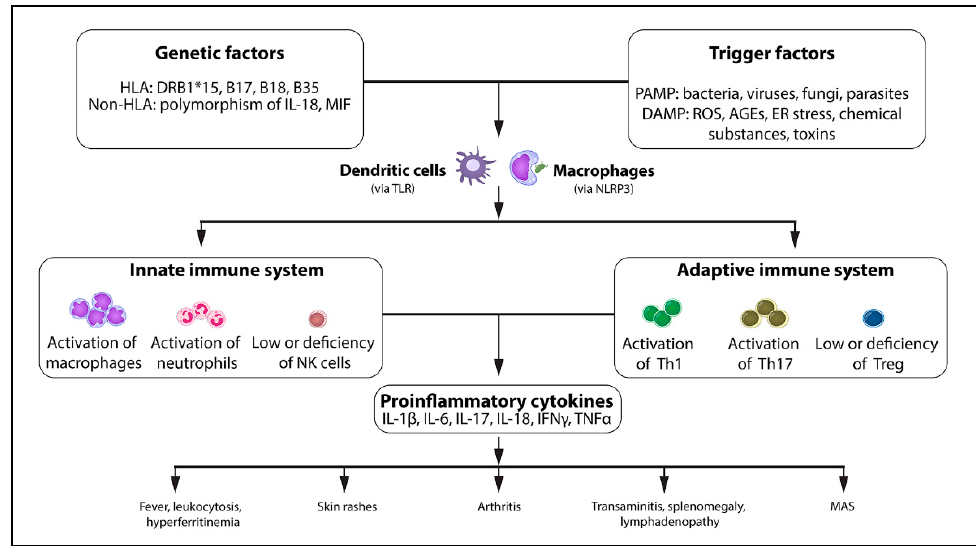
Figure 1. Pathogenesis of adult-onset Still’s disease (AOSD). AGEs = advanced glycation end products, DAMP = damage-associated molecular pattern, ER = endoplasmic reticulum, HLA = human leukocyte antigen, IFN = interferon, IL = interleukin, MAS = macrophage activation syndrome, MIF = macrophage inhibitory factor, NK cell = natural killer cell, NLRP3 = NOD-like receptor family pyrin domain-containing 3, PAMP = pathogen-associated molecular pattern, ROS = reactive oxygen species, Th1 = T helper 1, Th17 = T helper 17, TLR = Toll-like receptor, TNF = tumor necrosis factor, Treg = regulatory T cell.